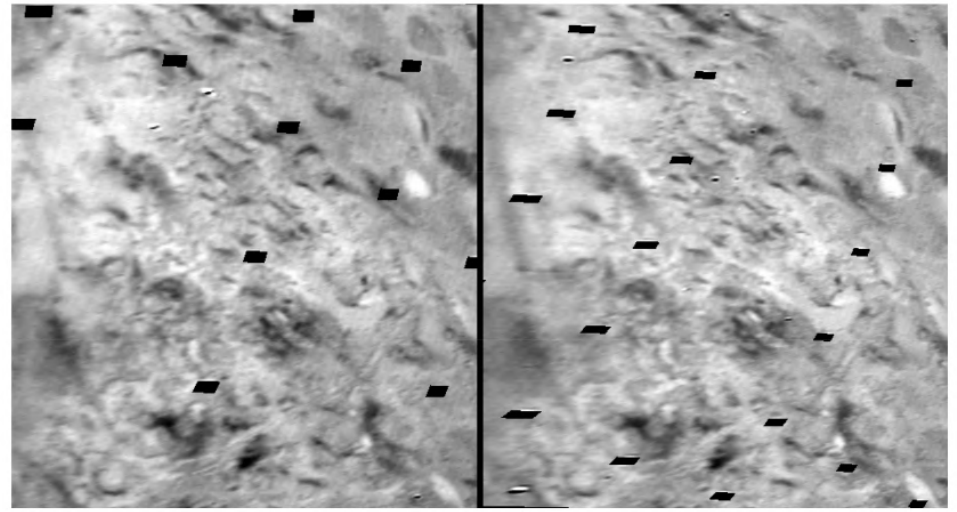
Figure 26. Best Voyager stereo pair of contact between lineated ST ( left ) and macular ST ( upper right ), with Hili plume and bright lobate materials at far left center. The more densely marked lineated terrains at center may be more rugged than the macular terrains at upper right with some of the darker deposits appearing to be higher standing, and narrow lobate brighter materials at lower left suggest a downslope flow. Stereo pairs such as these are difficult to interpret, however, due to the limited resolution, low solar incidence angle of <45 ◦ and low parallax. Scene width is ~400 km, centered at 44 ◦ S, 0 ◦ E; north is to